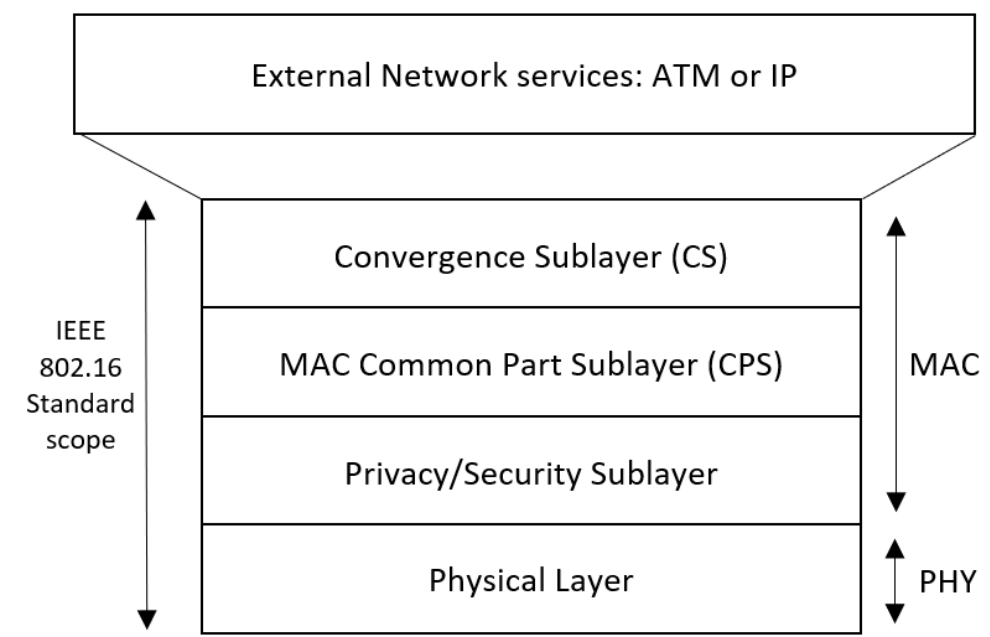
Figure 3. WiMAX protocol architecture [7].